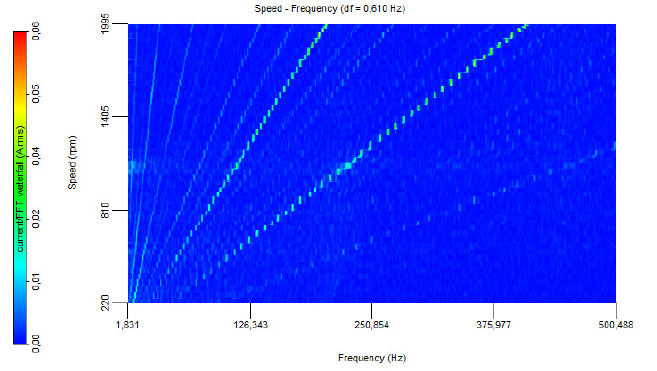
Figure 6. FFT waterfall plot.